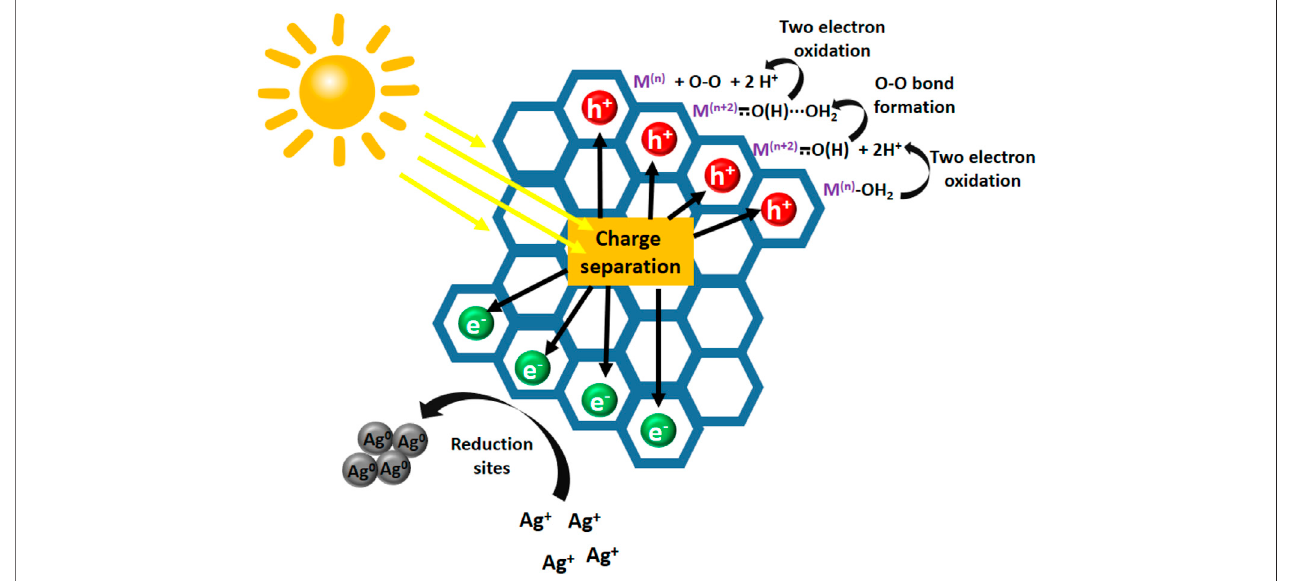
FIGURE 2 | Schematic representation of pathway commonly claimed for photocatalytic oxygen evolution